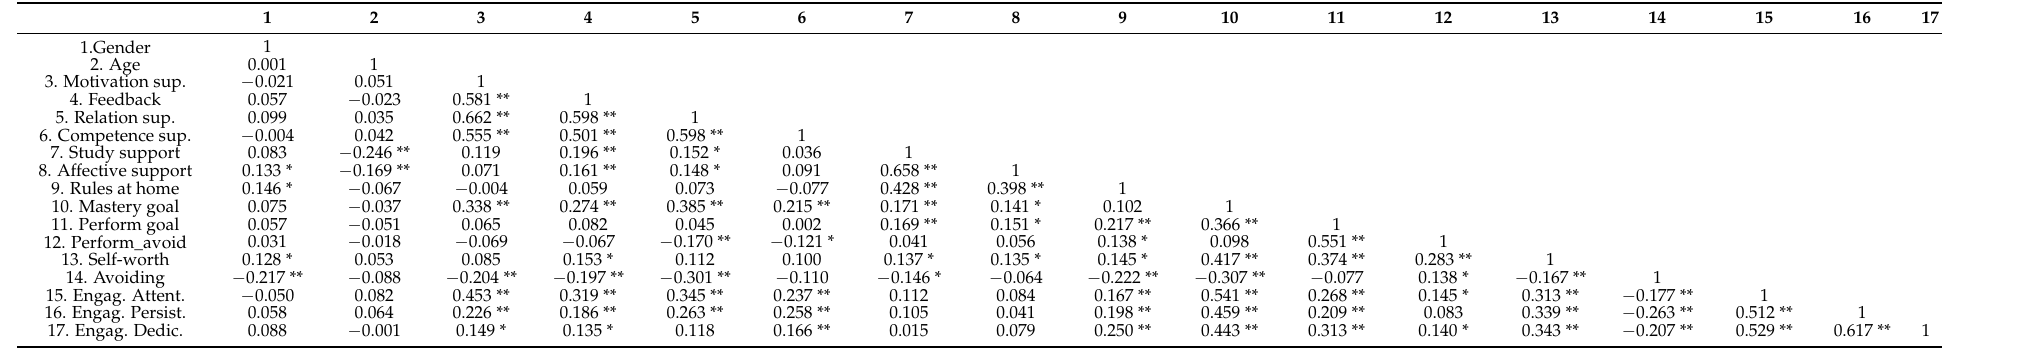
Table 3. Pearson’s bivariate correlations between the constructs considered in